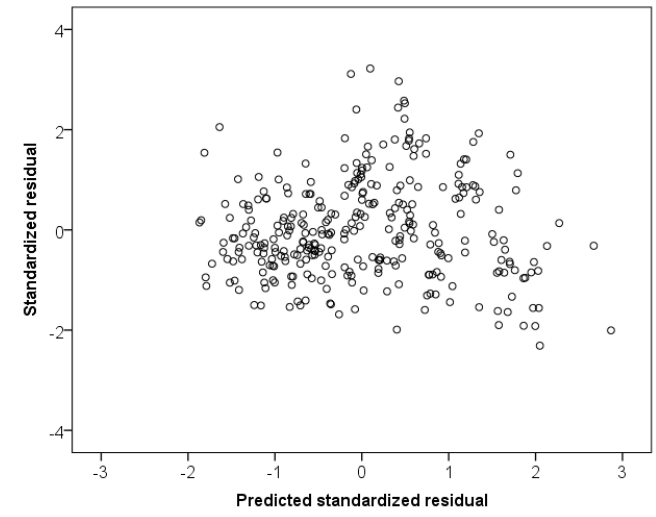
Figure 10. The scatter plots of the standardized residual data.